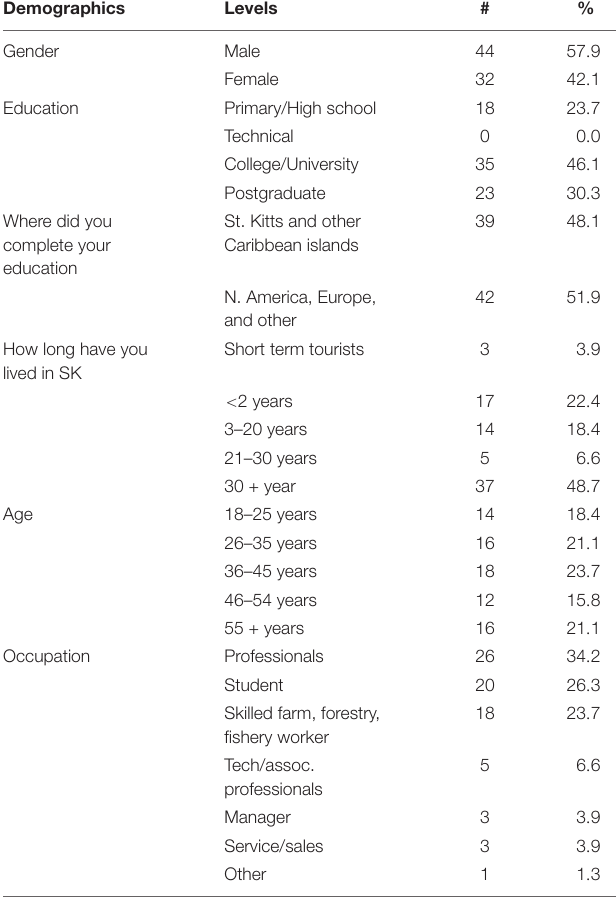
TABLE 2 | Stakeholder